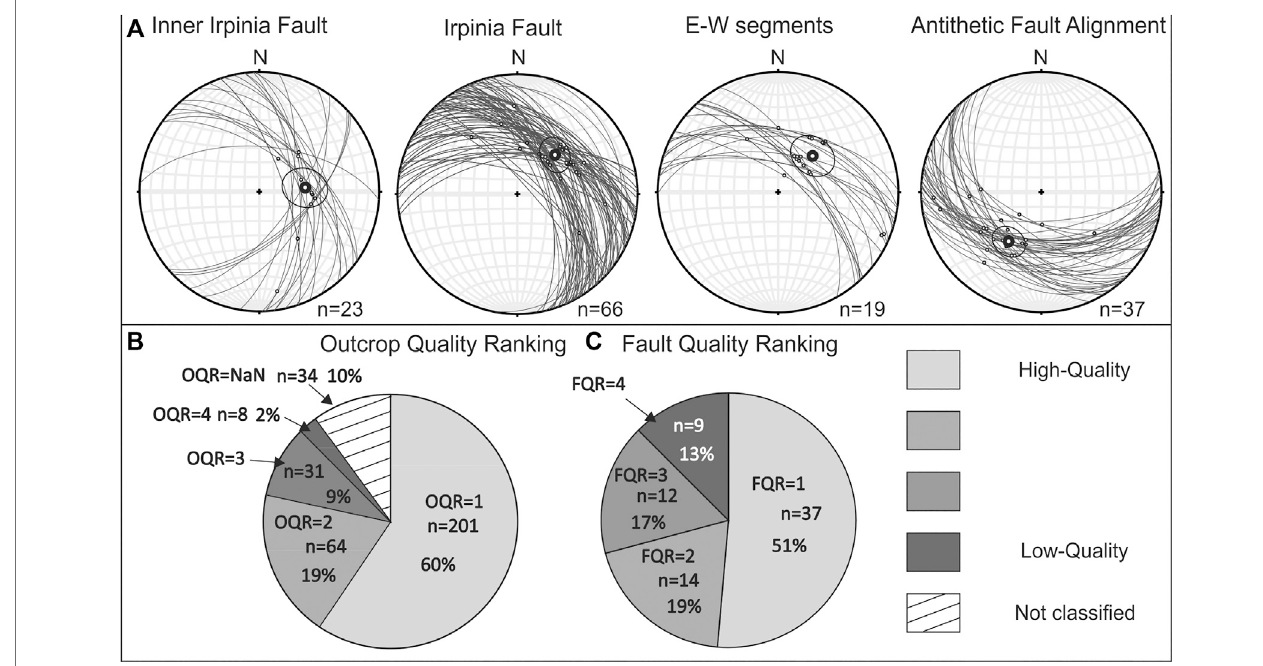
FIGURE 5 | Summary of structural data and quality parameters. (A) Faut/slip data (fault planes and slip vectors from slickenlines) summarized for the main faults reconstructed in this paper. The mean slip vectors are reported for each fault with the bold black circles; error calculated are reported with the thin black circles around the mean slip vectors. (B) Distribution of the measurements by the assigned four-class Outcrop Quality Rankings (OQR) (see also Supplementary Table S1 ). (C) Distribution of the mapped faults divided on the basis of the four-class Fault Quality Rankings (FQR) assigned (see also Supplementary Table S2 where FQR are reported close to the fault